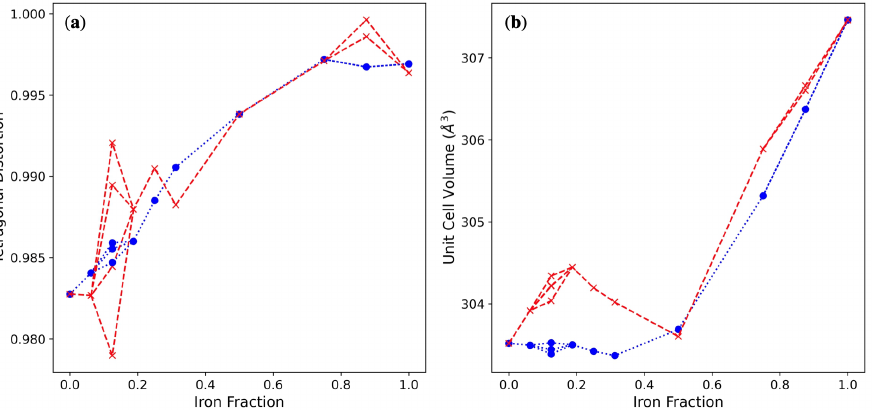
Figure 7. ( a ) Tetragonal distortion parameter η for both modes of Fe-substitution over the range 0 < p < 1; and ( b ) Unit cell volume for both modes of Fe-substitution over the range 0 < p < 1 (blue circles are α configurations and red crosses are β configurations. The multiple values at p = 0.125 and p = 0.875 correspond to the α 2.1 , α 2.2 , α 2.3 , β 2.1 , β 2.2 , β 2.3 and β 2.4 configurations and their inverted systems,